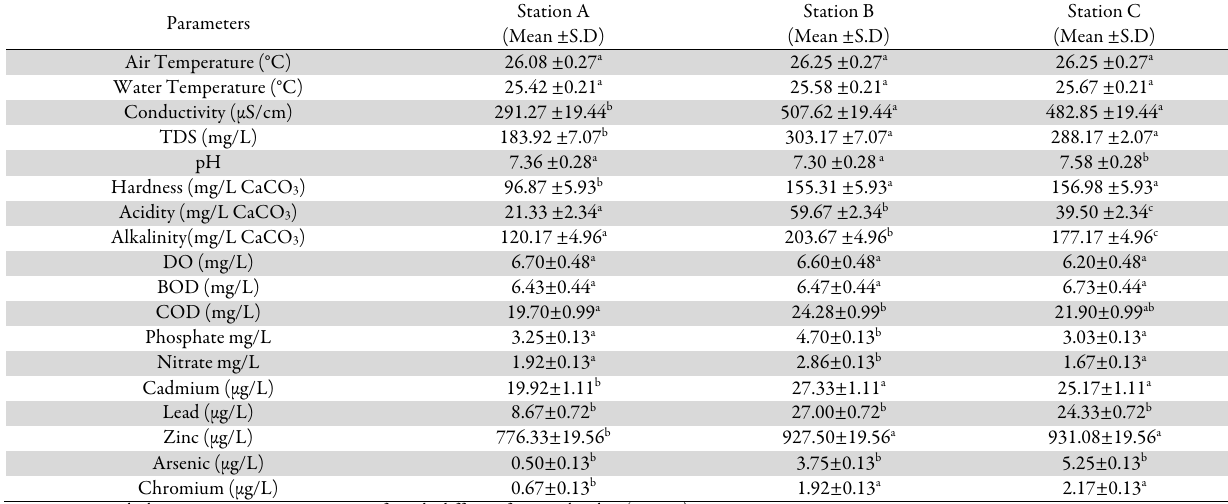
Table 2. Post-Hoc Multiple comparison (Duncan Multiple Range Test) to compare mean variations in physico-chemical and heavy metal parameters of the water across the sampling Stations